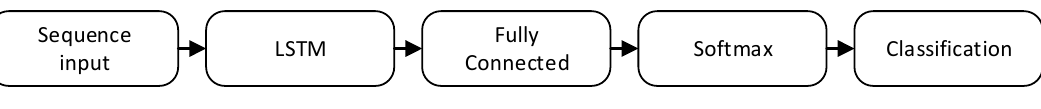
Figure 4. Long short-term memory (LSTM) network architecture.